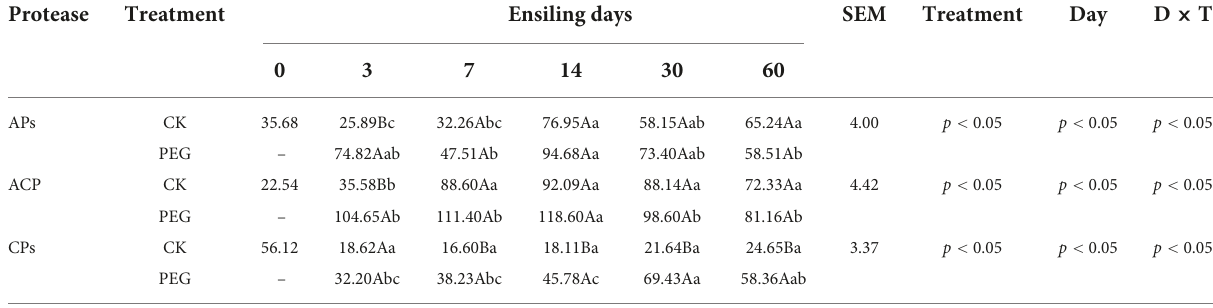
TABLE 2 Effects of intrinsic tannins on protease activity during sainfoin ensiling. Protease